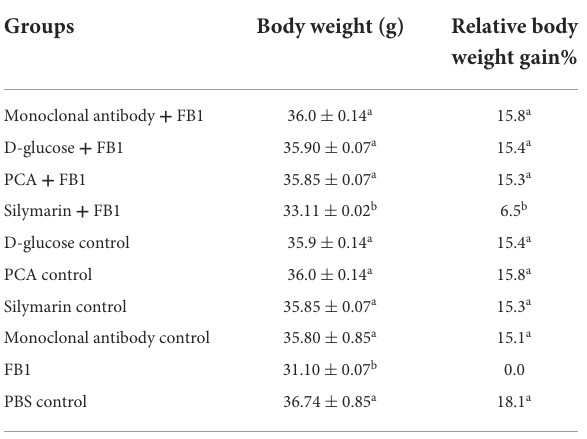
TABLE 2 Body weight of chickens of different treated groups.